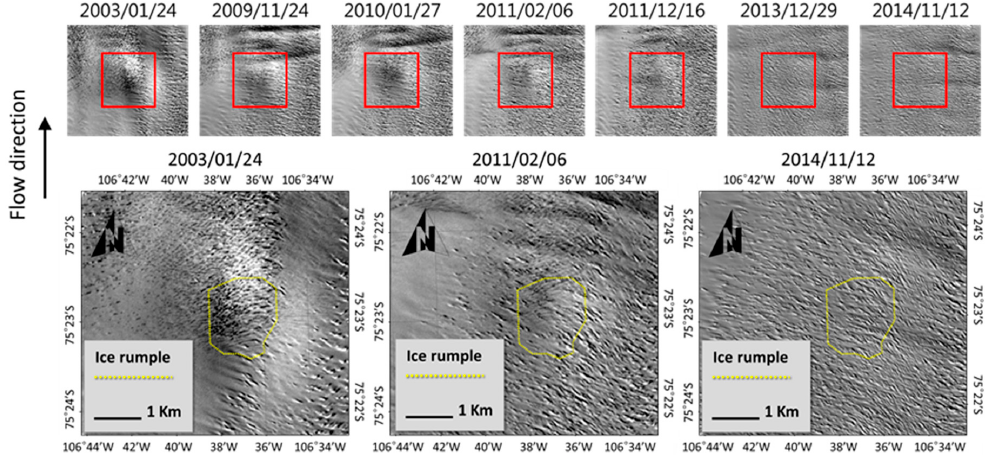
Figure 7. Landsat 7 ETM+ images from 2003–2014 showing the gradual disappearance of the studied ice rumple in the Thwaites ice shelf. Crevasses and surface gradients are generally created atop an ice rumple due to surface extension and elevation increase. Such features were visible as late as 2011 but disappeared by 2013, indicating gradual ice thinning. Larger images are magnifications of selected areas indicated by red boxes. The yellow dotted line was extracted from the grounding line of the MEaSUREs dataset [13,15].